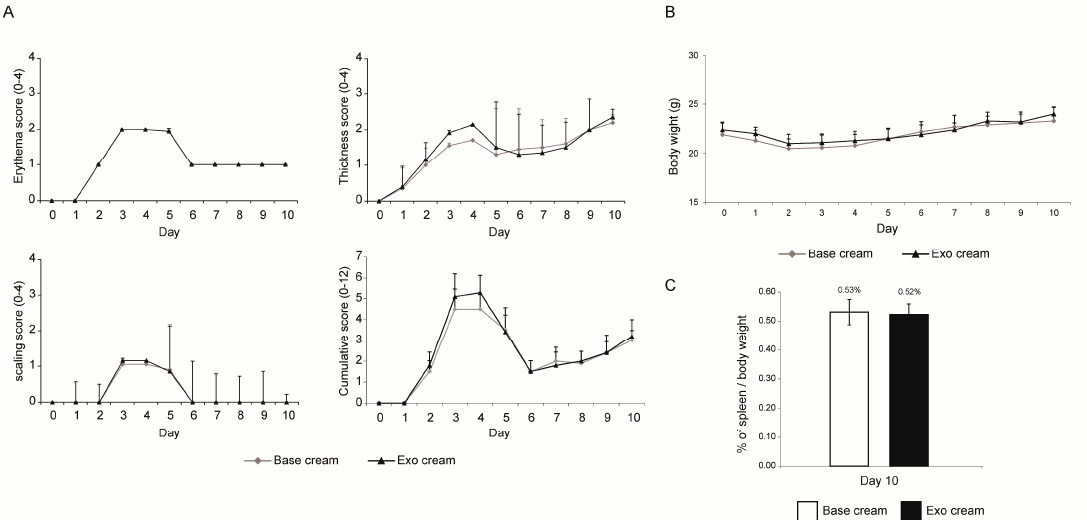
Figure 3. Skin phenotype score, body weight and ratio of spleen to body weight. ( A ) Erythema, scaling, and thickness of the back skin were scored independently daily from Day 0 to Day10 (Expt. 2) on a scale from 0 to 4, and the cumulative score for erythema, scaling, and thickness over time was determined daily on a scale from 0–12. ( B ) The body weight (Day 0–10) and ( C ) ratio of spleen to body weight (Day 10) were also determined. Two independent animal experiments using different batches of exosome preparations were performed. The scores from the two independent studies were combined. Scoring (erythema, scaling, thickness, and cumulative score), body weights and ratio of spleen to body weight were ana- lyzed using Student’s t-test. p values < 0.05 were considered as statistically significant.